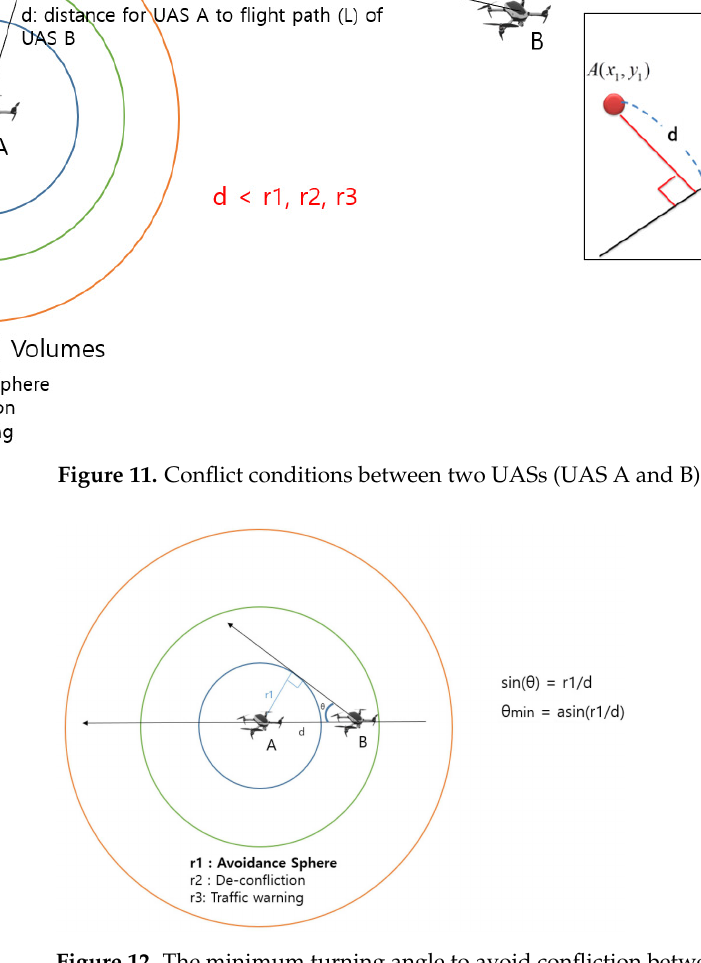
Figure 12. The minimum turning angle to avoid confliction between